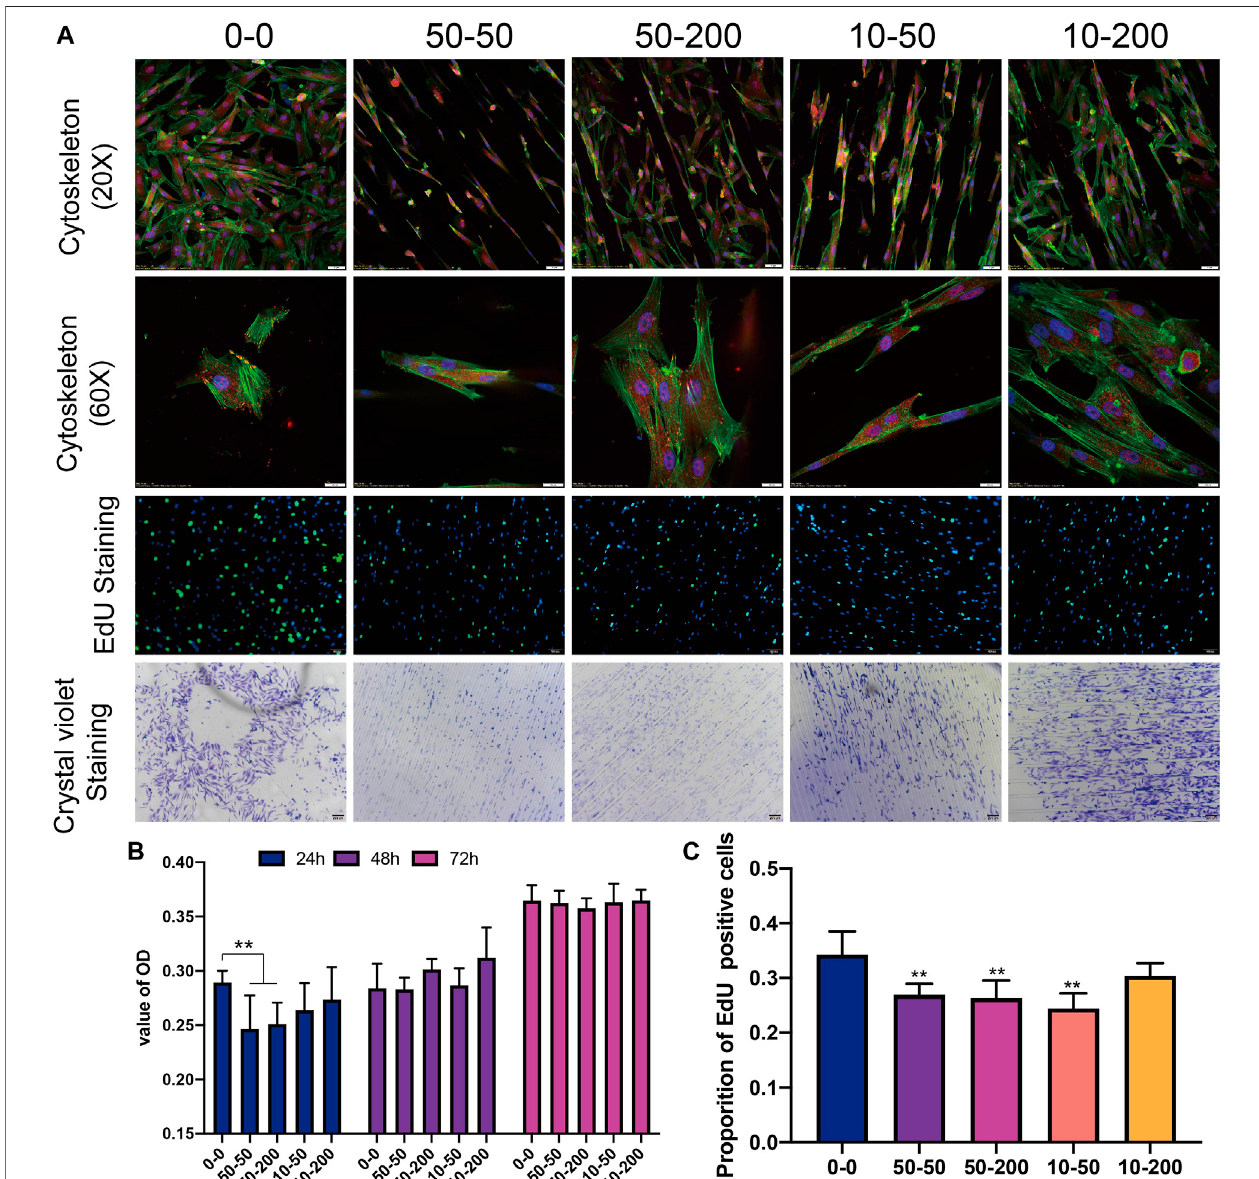
FIGURE4| Effectsofsurfacetopologyon fi broblastadhesion,proliferation. (A) Representativeresultsofoverall(20 × )andlocal(60 × )characteristicsofcytoskeleton staining,EdUstaining(scalebaris100 μ m),andcellcrystalvioletstaining(scalebaris200 μ m). (B) StatisticalanalysisofCCK8. (C) EdUpositiverate.Datacomparisons were implemented utilizing one-way ANOVA, and the values were expressed as mean ± standard deviation (SD). n (cid:2) 5, ** p < 0.01 vs 0 – 0.